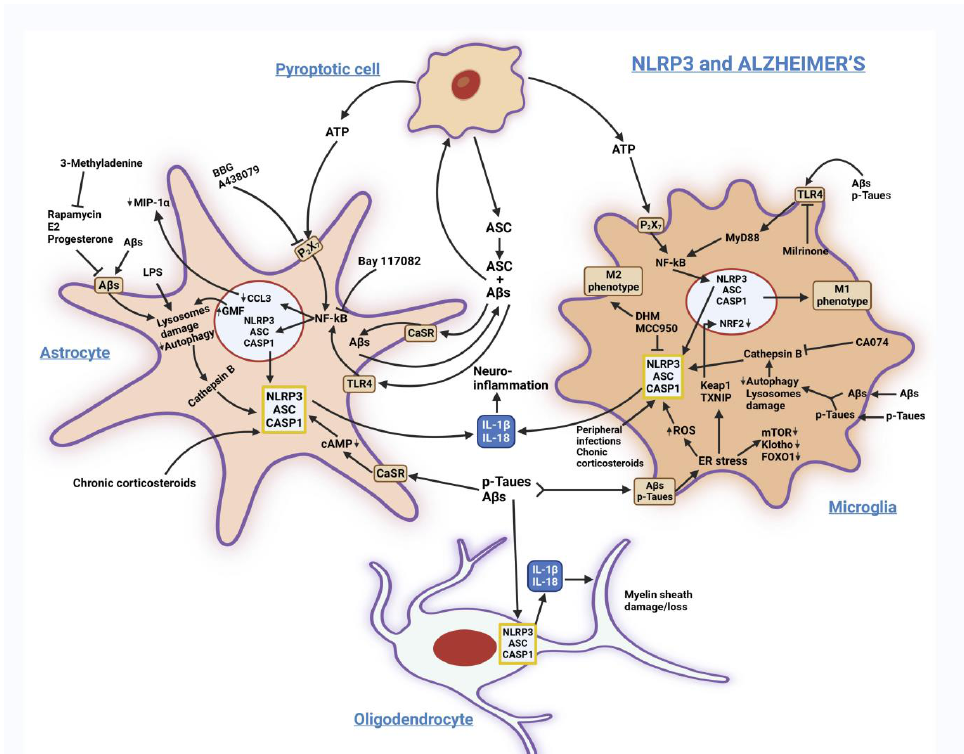
Figure 2. Schematic depiction of stressors and factors inducing/modulating glial cell NLRP3 in- flammasome activation and its consequences in AD. Exogenous A β s, p-Taues, ATP, ASC, IL-1 β , and IL-18 interact with cell surface receptors, including CaSR (see Box 1), TL-4, and P2X 7 (see Box 2), or are endocytosed to activate NF- κ B and NLRP3 inflammasome signaling. They also induce ER stress, release Cathepsin B from damaged lysosomes, and block autophagy, while over- releasing further amounts of A β s, p-Taues, and inflammatory cytokines. Altogether, they damage myelin sheaths and cause M1 microglial phenotype polarization and neuron and oligodendrocyte pyroptotic death. NLRP3 and receptor inhibitors mitigate the just-mentioned noxious effects. Ad- ditionally, the CaSR NAM NPS-2143 blocks A β s, p-Taues, and IL-6 over production and release and reactivates autophagy (not shown; [181,199,354]). Regarding the roles of other-than-NLRP3 inflammasomes, see [24]. A yellow frame encloses the assembled NLRP3 inflammasomes, while nuclear envelopes are orange-colored. Abbreviations: A438079 = 3-[[5-(2,3-dichlorophenyl)tetrazol- 1-yl]methyl]pyridine; A β s = amyloid- β peptides; ASC = apoptosis-associated speck-like protein endowed with a CARD; Bay117082 = (E)-3-(4-methylphenyl)sulfonylprop-2-enenitrile; BBB = blood- brain barrier; BBG = brilliant blue G; cAMP, 3 (cid:48) ,5 (cid:48) -cyclic adenosine monophosphate; CA074 = CAS 134448-10-5; CASP1 = caspase-1; CaSR = calcium-sensing receptor; CCL3 = gene encoding MIP-1 α chemokine; DHM = dihydromyricetin; E2 = estradiol; FOXO1 = forkhead box protein O1; GMF, glia maturation factor; JAK2 = Janus kinase 2; Keap1 = Kelch-like ECH-associated protein 1; KN93 = N-[2-[[[(E)-3-(4-chlorophenyl)prop-2-enyl]-methylamino]methyl]-phenyl]-N-(2-hydroxyethyl)-4- methoxybenzenesulfon-amide; LPS = bacterial lipopolysaccharide; MCC950, CAS 210826-40- 7; MIP-1 α = monocyte chemoattractant protein-1 α ; mTOR = mammalian target of rapamycin; MyD88 = myeloid differentiation primary response 88; NF- κ B = nuclear factor κ B; P2X 7 = purinergic receptor; p-Taues = hyperphosphorylated Tau proteins; STAT3 = signal transducer and activa- tor of transcription 3; TLR-4 = Toll-like receptor 4; TPRV1, vanilloid type 1 receptor/channel; TXNIP = thioredoxin interacting protein. The small arrows close to a name indicate ( ↓ ) decrease, or ( ↑ ) increase in levels. ⊥ = inhibition. The other arrows show the sequences of molecular events induced by stressors and